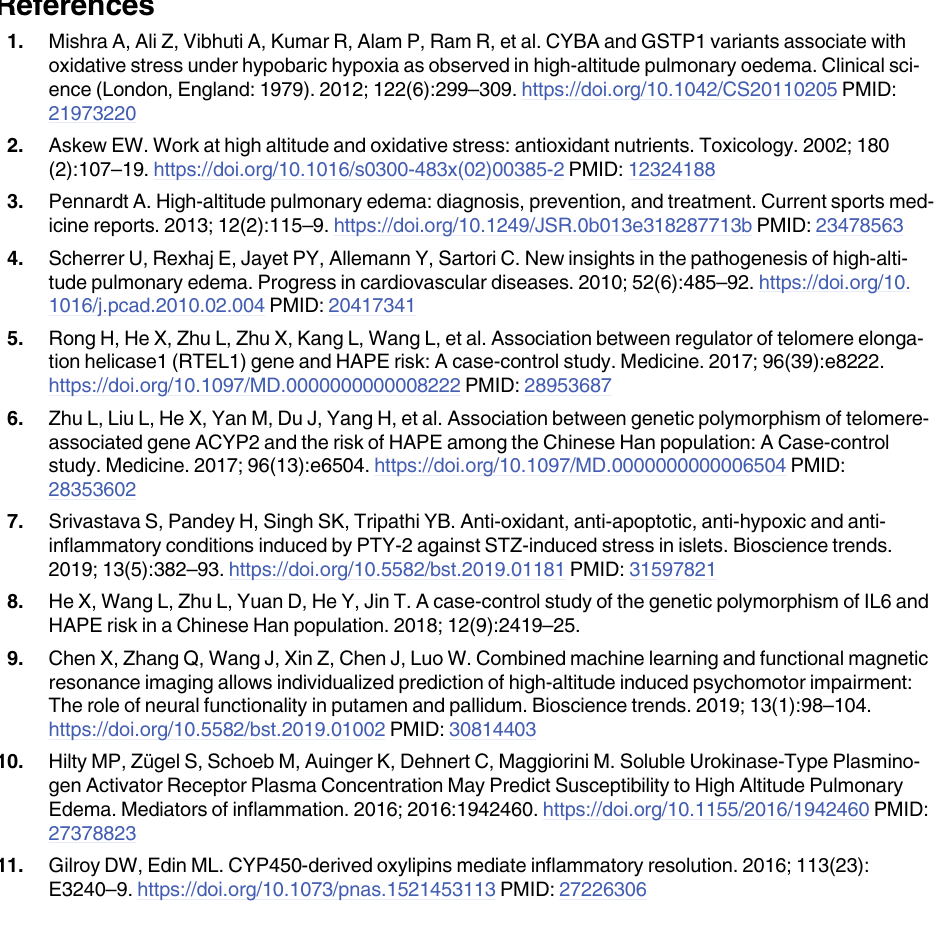
S1 Fig. Functional enrichment analysis for HAPE susceptible genes and CYP4F2 related genes. (A) The protein and protein interaction of HAPE susceptible genes and CYP4F2 related genes. (B) Gene ontology analysis. The x-axis shows significantly enriched GO categories asso- ciated with the targets; the y-axis shows the enrichment scores ( P value) of these terms. (C) The KEGG analysis. The KEGG pathway with corresponding adjusted p-values analyzed by clusterProfiler. The color scales indicated the different thresholds of adjusted p-values.